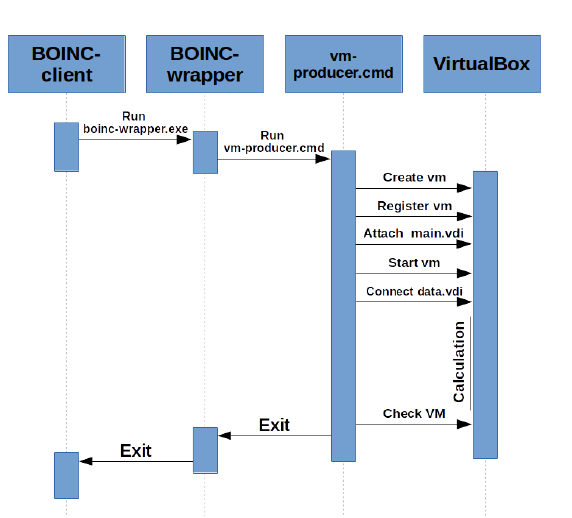
Figure 1: Workunit’s processing